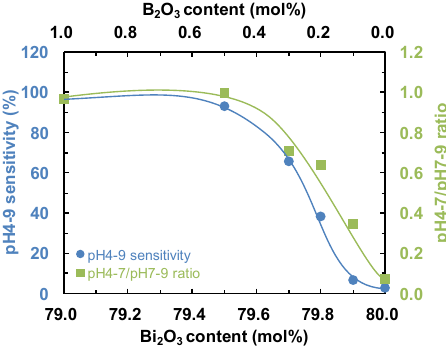
Figure 2. Dependence of pH4-9 sensitivity (left axis) between pH4 and pH9, and pH4-7/pH7-9 sensitivity ratio (right axis) on Bi 2 O 3 and B 2 O 3 contents for 20Fe y BiB glasses.